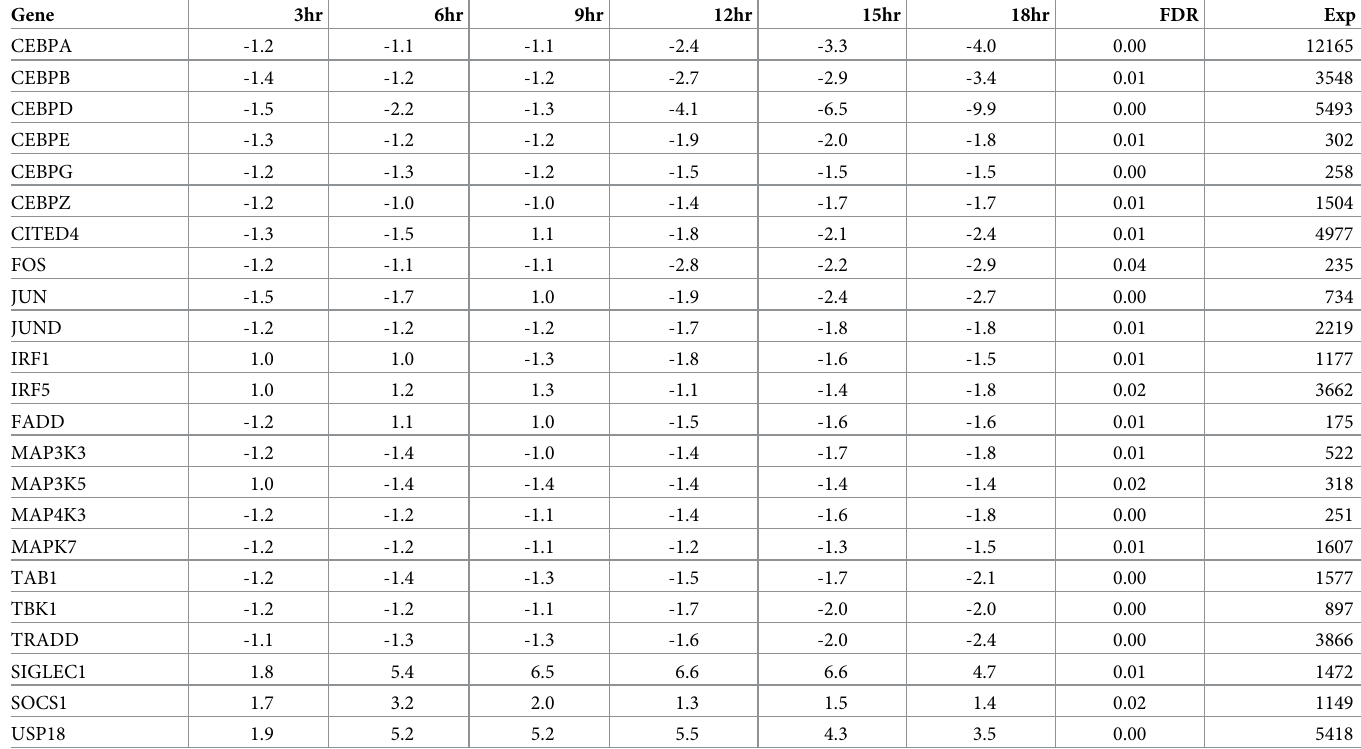
Table 9. Differential expression (fold = infected/non-infected) with a FDR less than 0.05 at one or more time points and the averaged expression level (Exp) of immune-related transcription factor, signal transducer and signaling inhibitor genes between infected and non-infected macrophages at 3, 6, 9, 12, 15 and 18 hours post